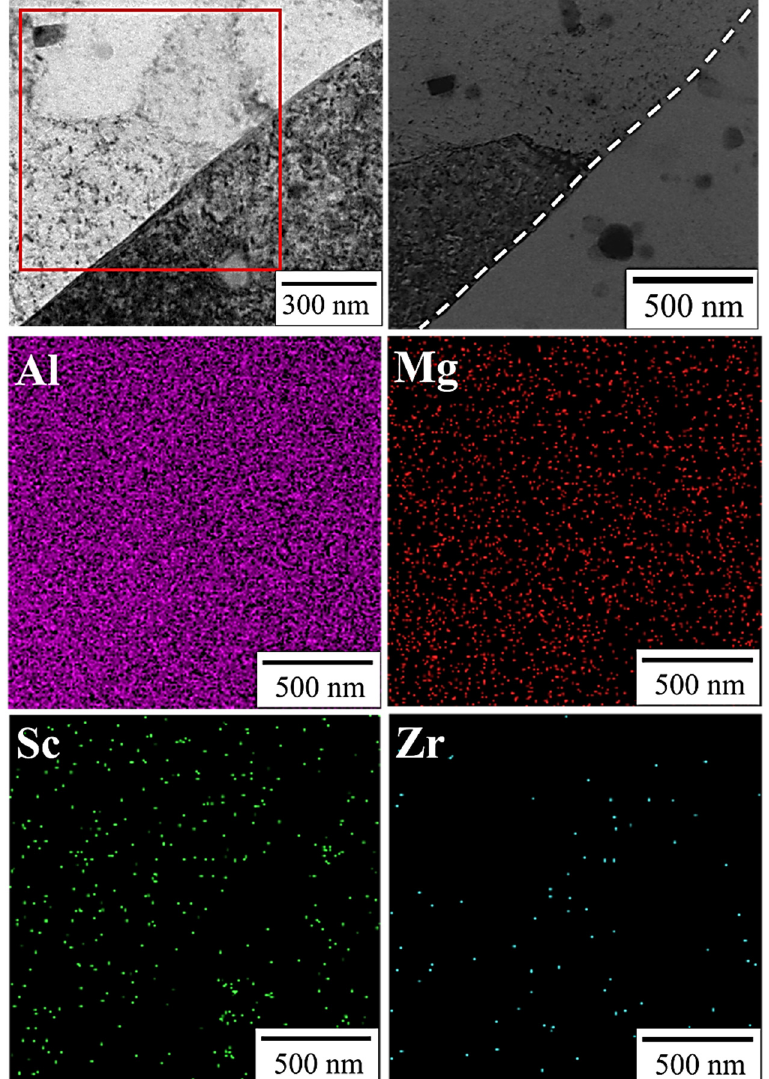
Figure 12. TEM image and EDS mapping of two-stage-heat-treated specimen.